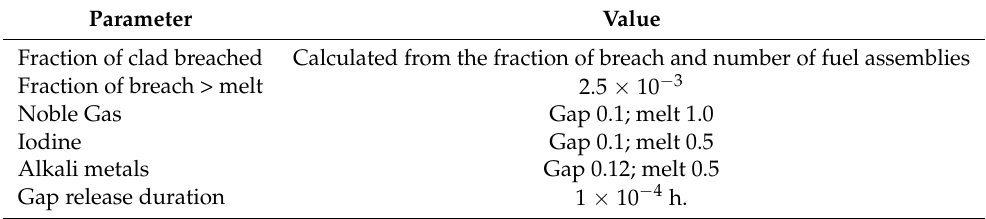
Table 2. Rod ejection accident analysis parameters using RADTRAD.